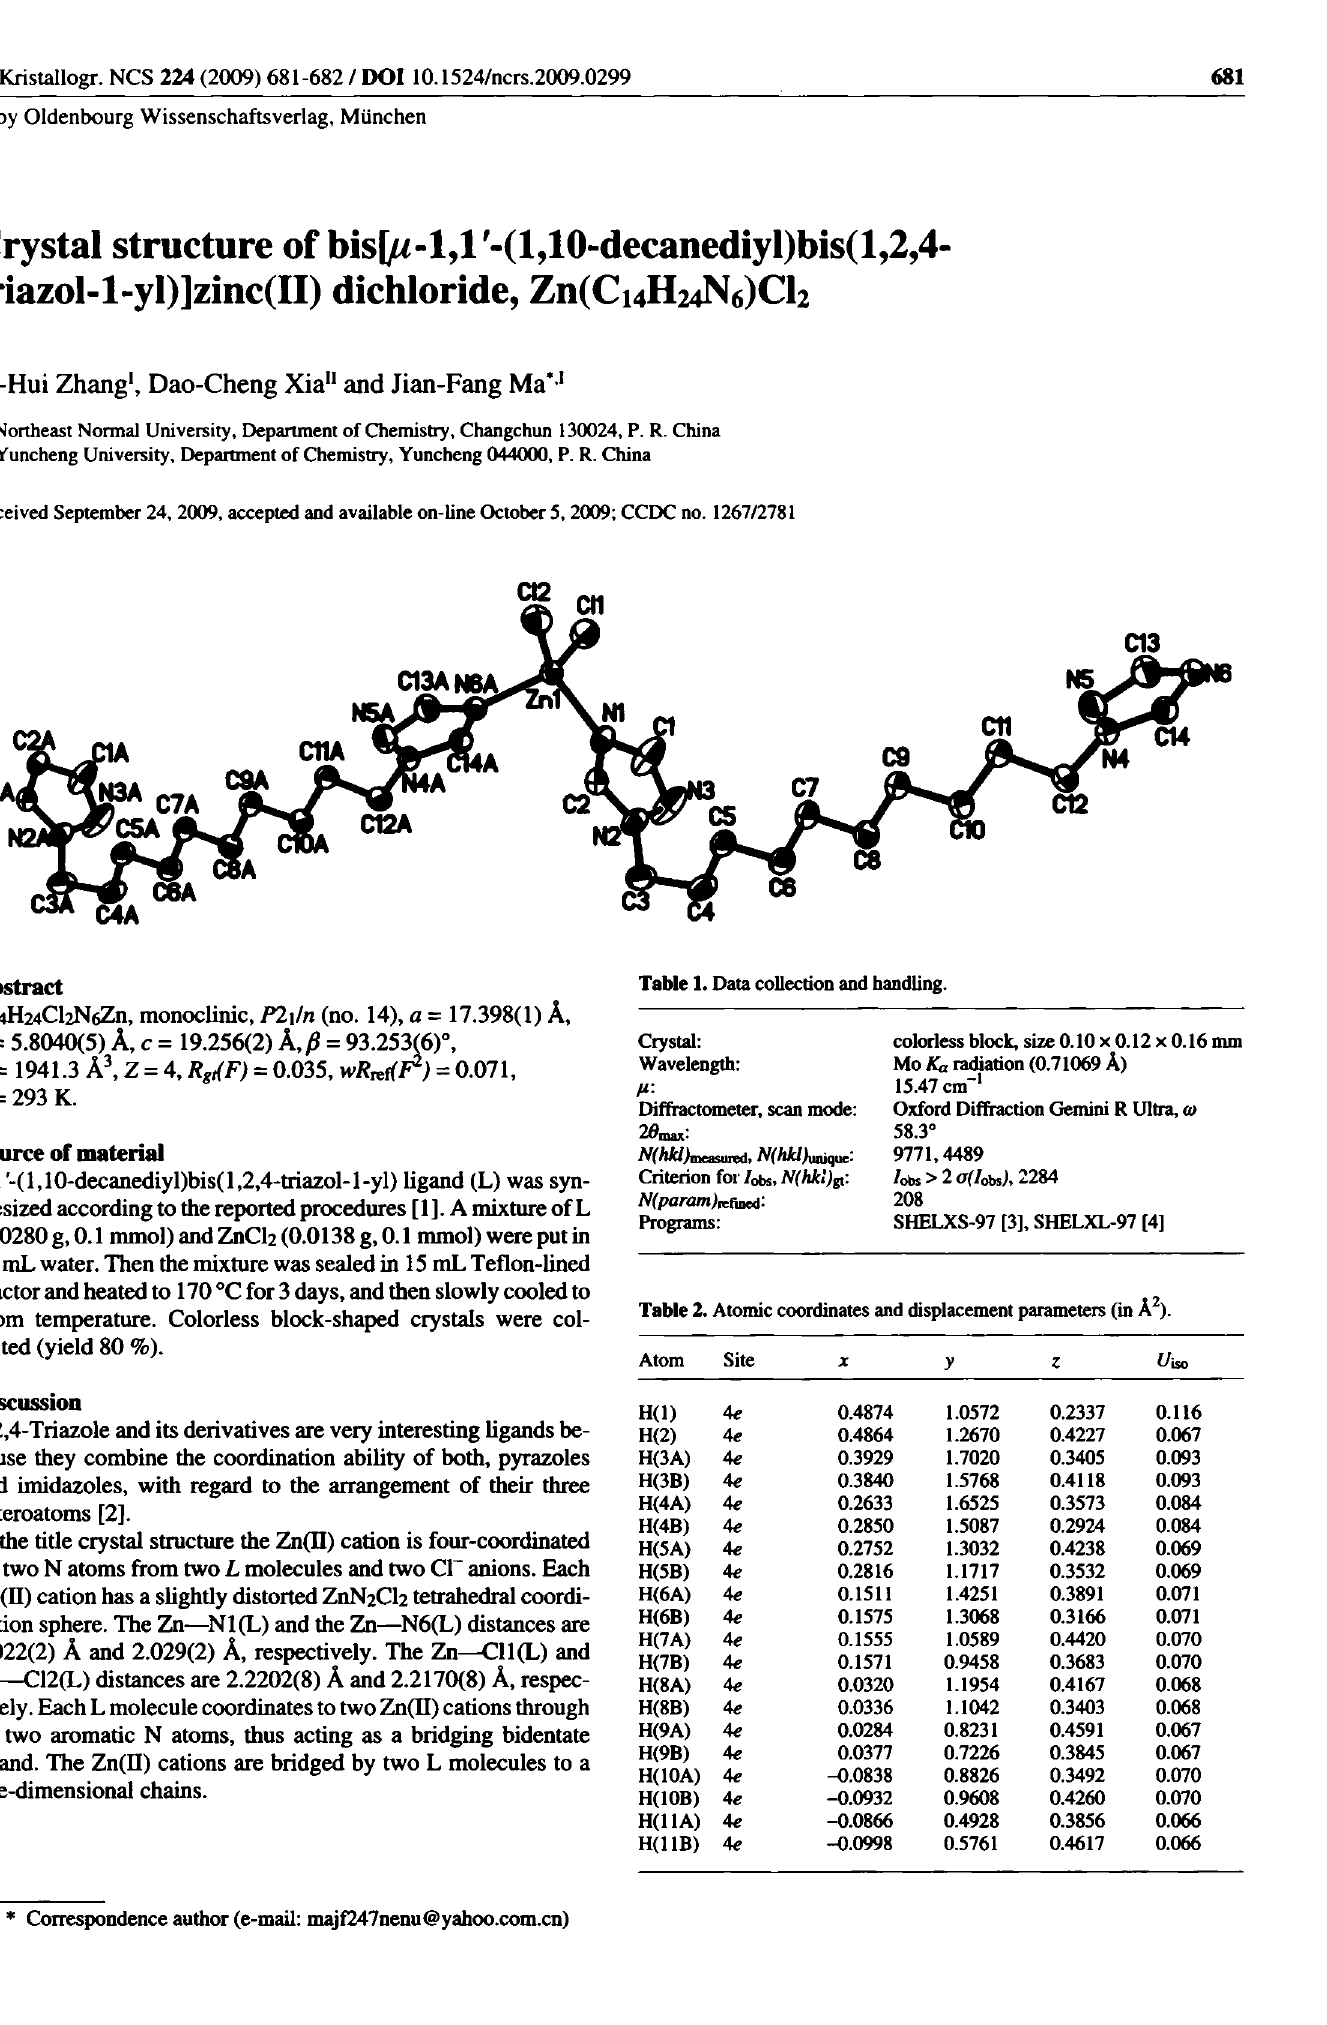
Table 2. Atomic coordinates and displacement parameters (in Â 2